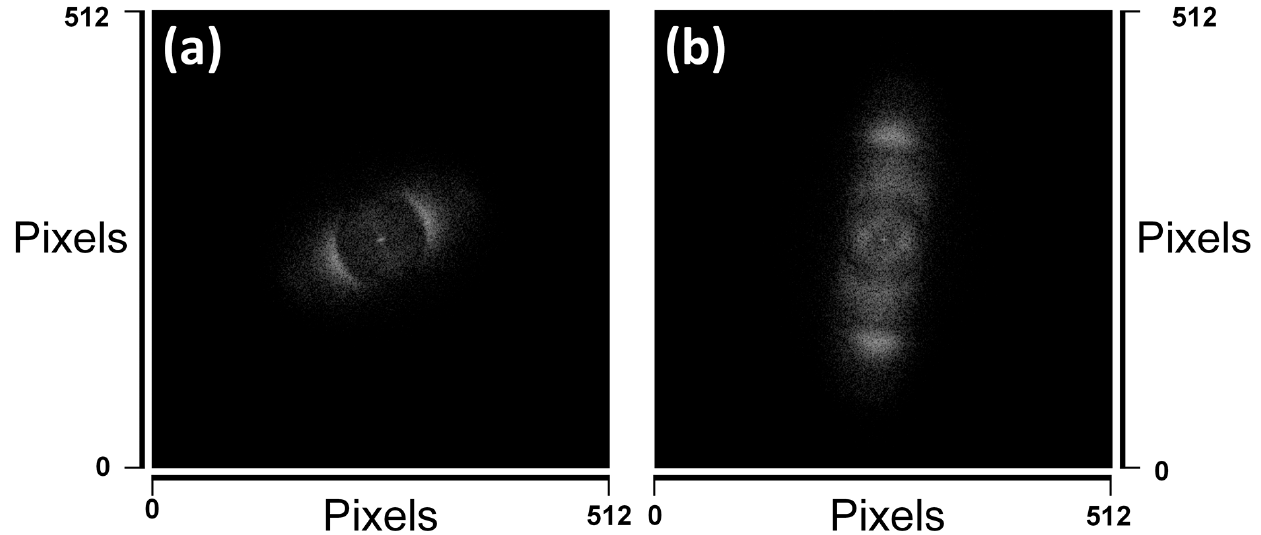
Figure 5. 2D Fourier transform of ( a ) Mo-1.5/MS and ( b ) MoOx/MS micrographs shown in Figure S4. The view field in either case is 48.1 μm